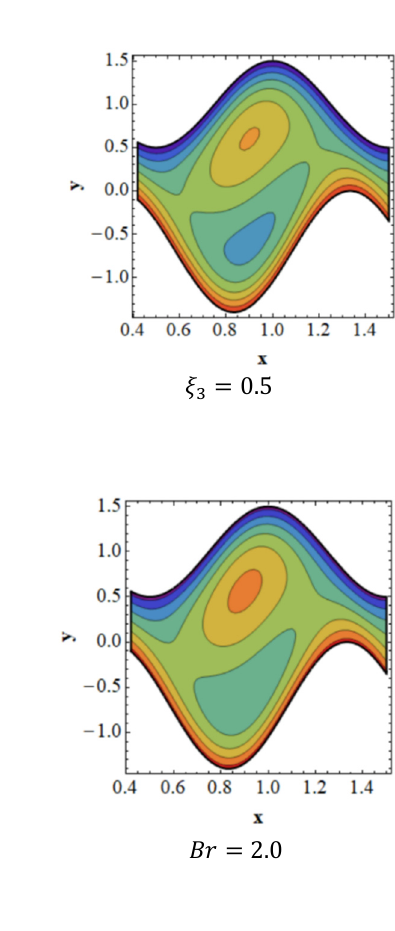
Figure 8. Consistency of streamlines for values of 𝜉 (cid:2869) .